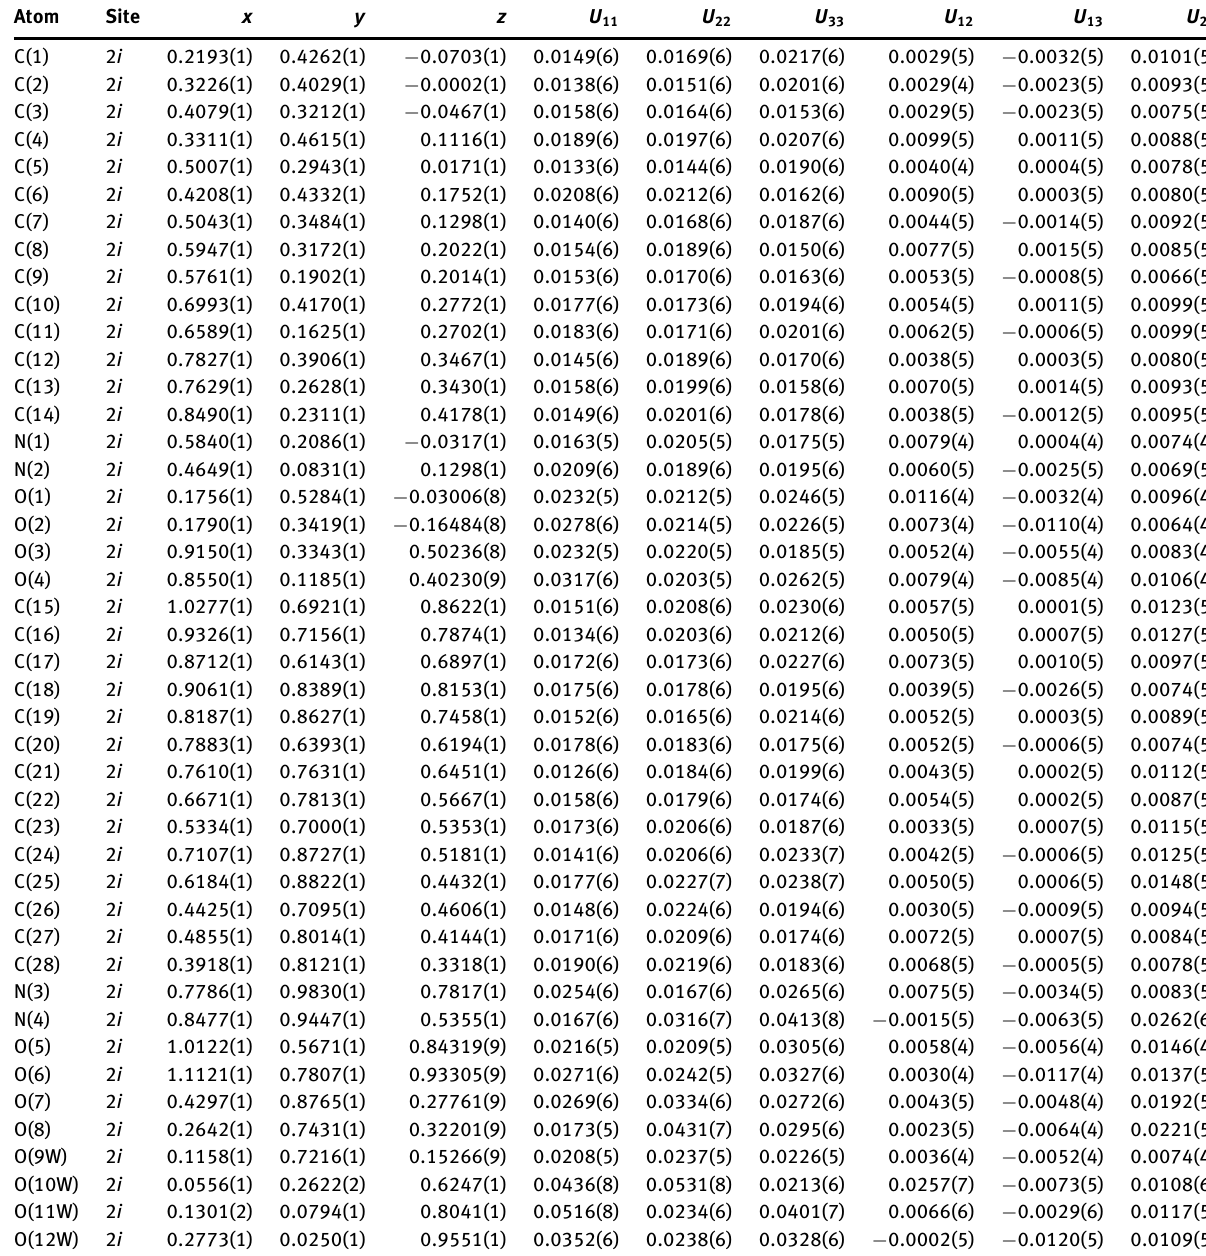
Table 3: Atomic displacement parameters (Å 2